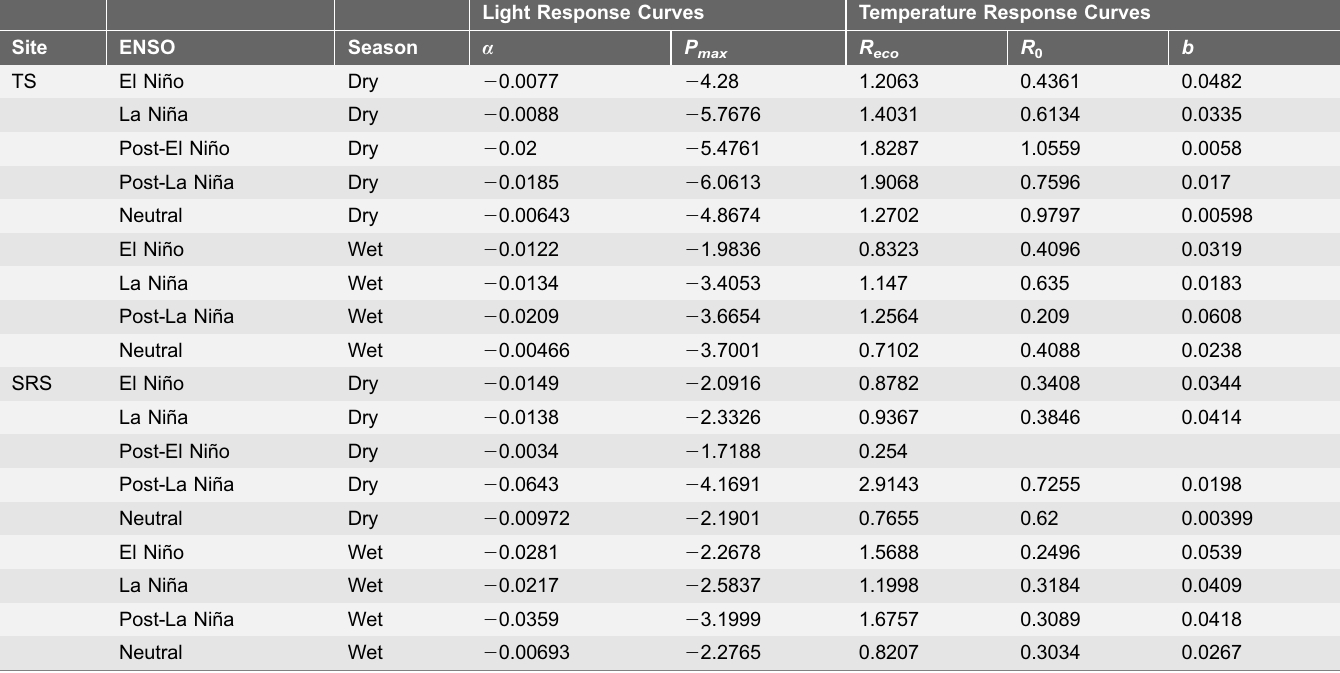
Table 3. Model estimates from Eq.6 and 7 for TS and SRS by ENSO phase and